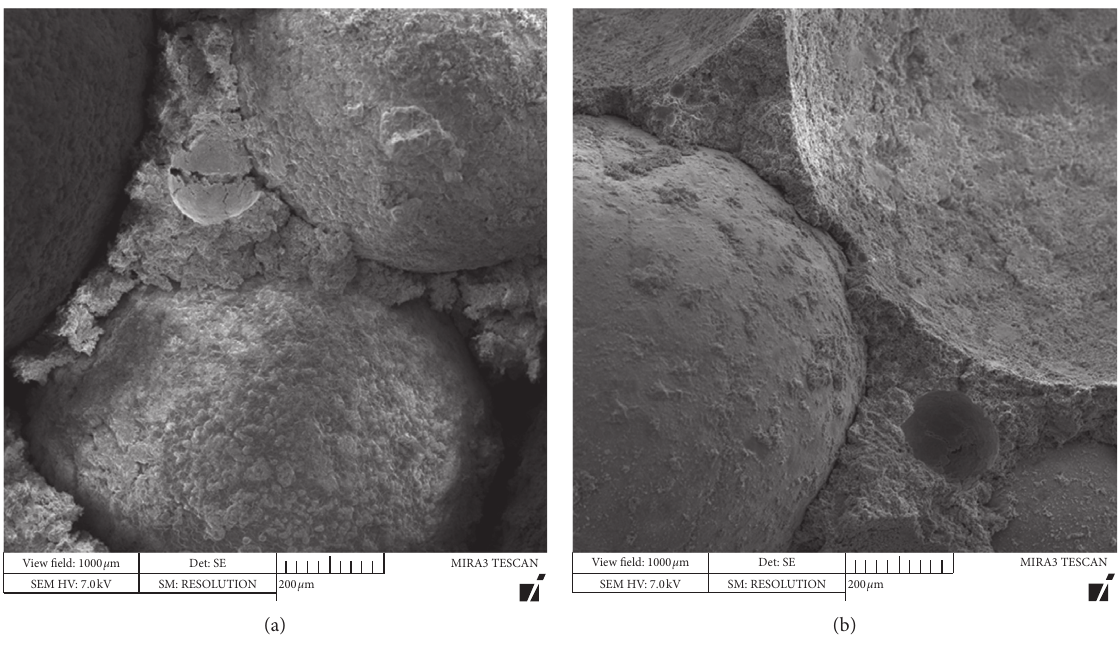
Figure 8: Surface microstructure (SEM) of a fracture of a cement composite chip based on unmodified (a) and modified (b) shot of titanium hydride subjected to c -irradiation, at a dose D �